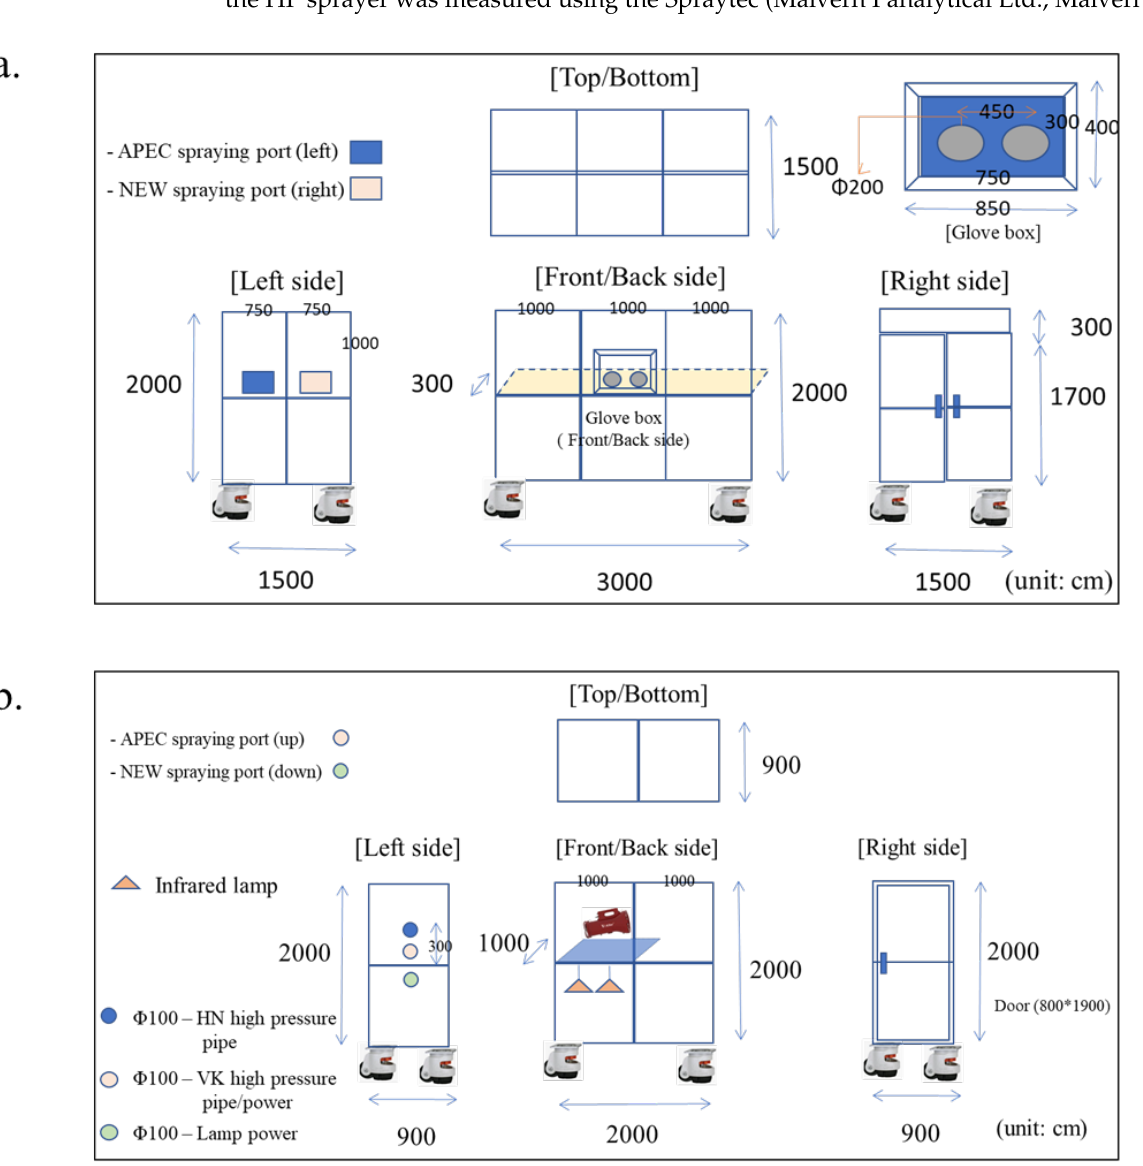
Figure 1. The designs of laboratory-scale chambers. Chamber (3.0 m × 1.5 m × 2.0 m) was used to determine the effective concentrations of NEW on the reduction in APEC strains in the space ( a ). Chamber (2.0 m × 1.0 m × 2.0 m) was used to measure the antimicrobial activity of NEW against APEC ( b